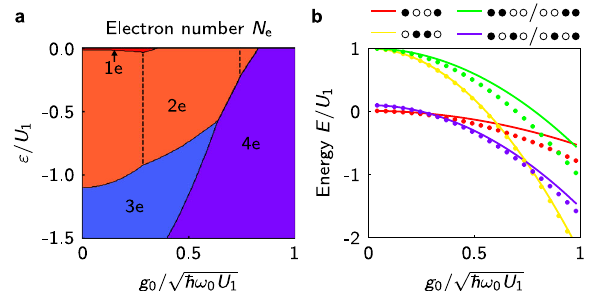
Fig. 2 Role of electron-phonon coupling in the equilibrium system at atomic limit t 0 = 0. a Electron number N e in equilibrium as a function of local chemical potential ε / U 1 and electron-phonon ffiffiffiffiffiffiffiffiffiffiffiffiffi p = _ ω . b Energy of different electron coupling strength g 0 U 1 0 con fi gurations with fi xed N e = 2. Here we have used the single- mode approximation, which is veri fi ed by comparing the results obtained from single mode (solid lines) and multi (e.g., 100 considered here) modes (dots). The single- and multi-mode scenarios are found to agree with each other qualitatively well. The transition points between patterns ●○○● ( ○●●○ ) and ●○●○ / ○●○● are also presented in the two-electron region of ( a ) by dashed lines, respectively. Here we set U 1 /2 π ℏ = 200 GHz, U 2 /2 π ℏ = 20 GHz, U 3 /2 π ℏ = 2 GHz, and ω 0 /2 π = 3 GHz, which are within the typical tuning range of parameters shown in Fig.